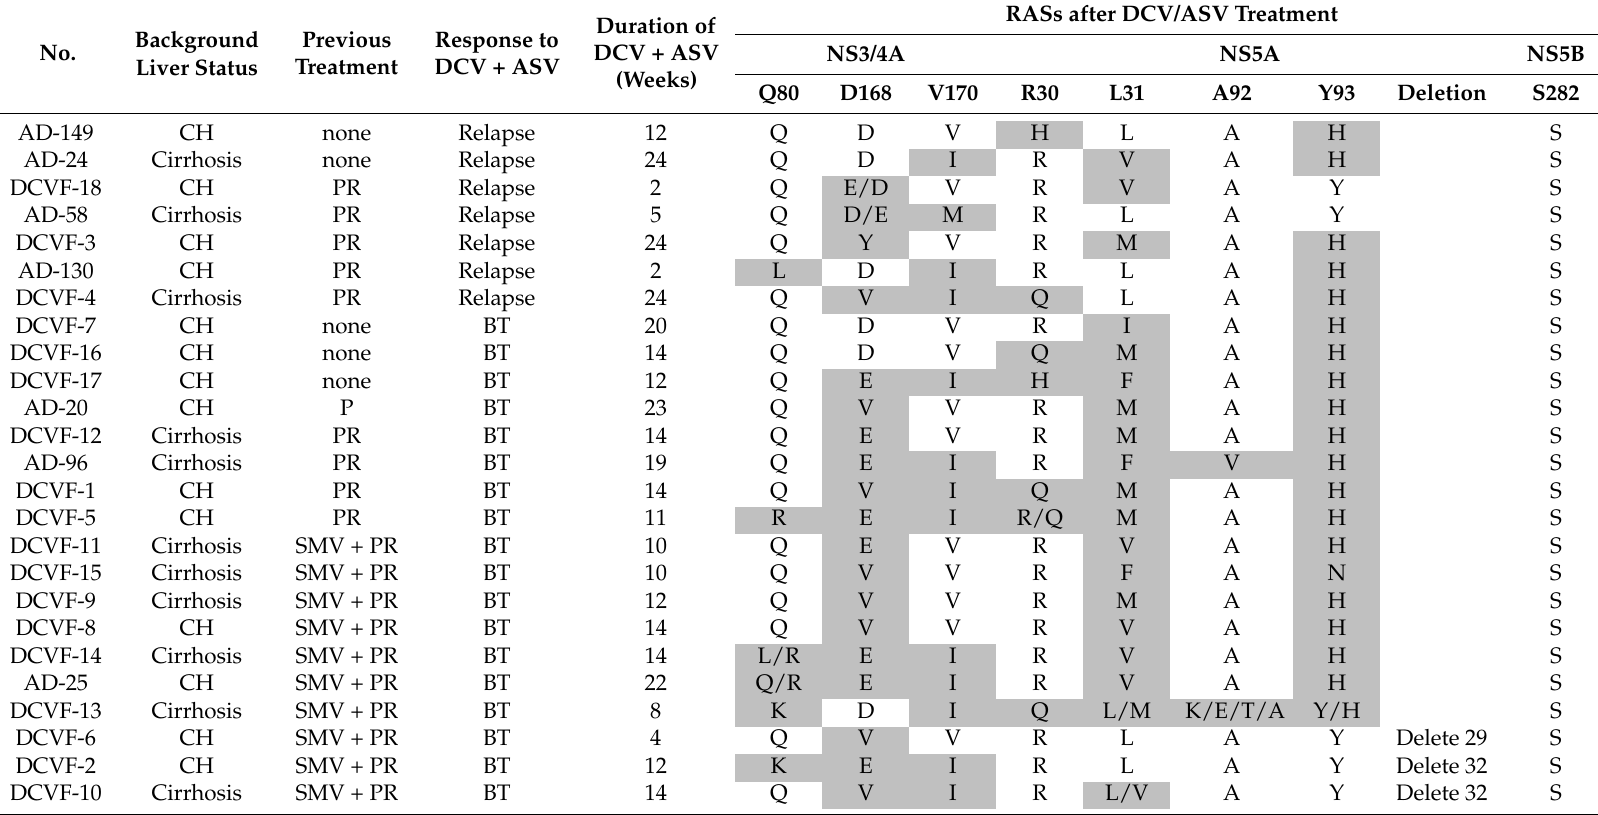
Table 2. Overview of RASs after daclatasvir/asunaprevir (DCV/ASV)